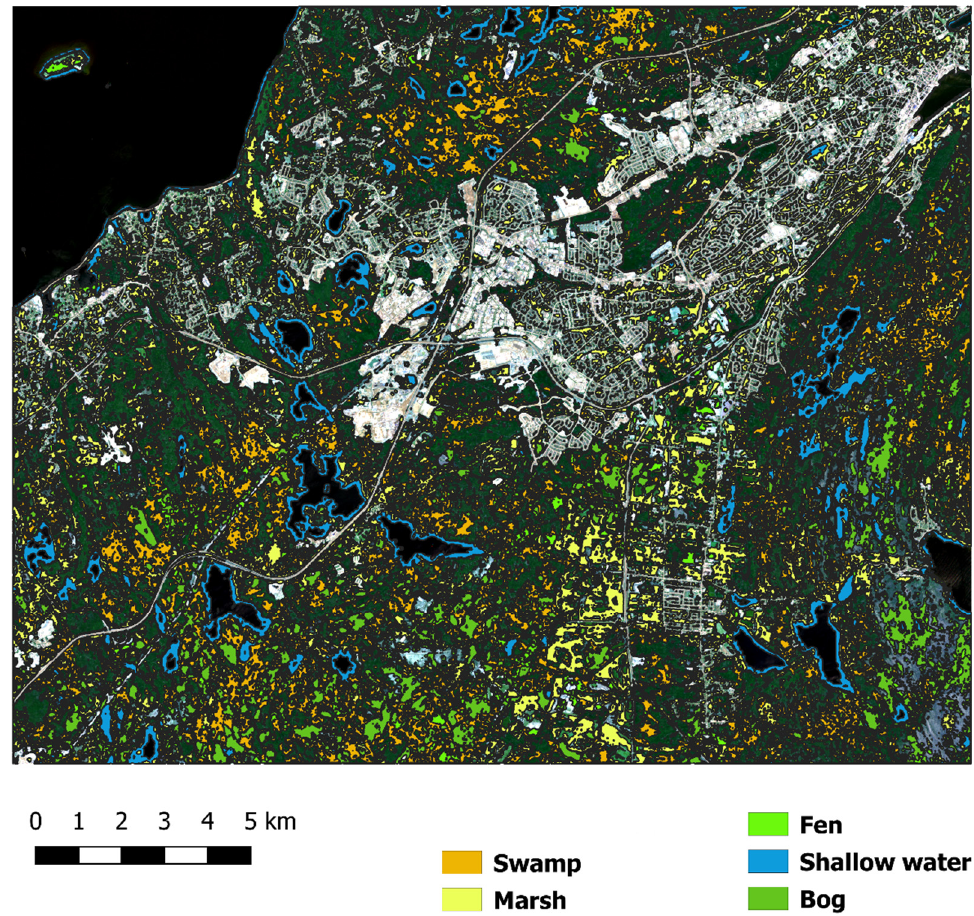
Figure 6. Spatial distribution of bog, fen, marsh, swamp, and shallow water wetland overlaid on the Sentinel-2 true-color image of the pilot site of the Avalon.